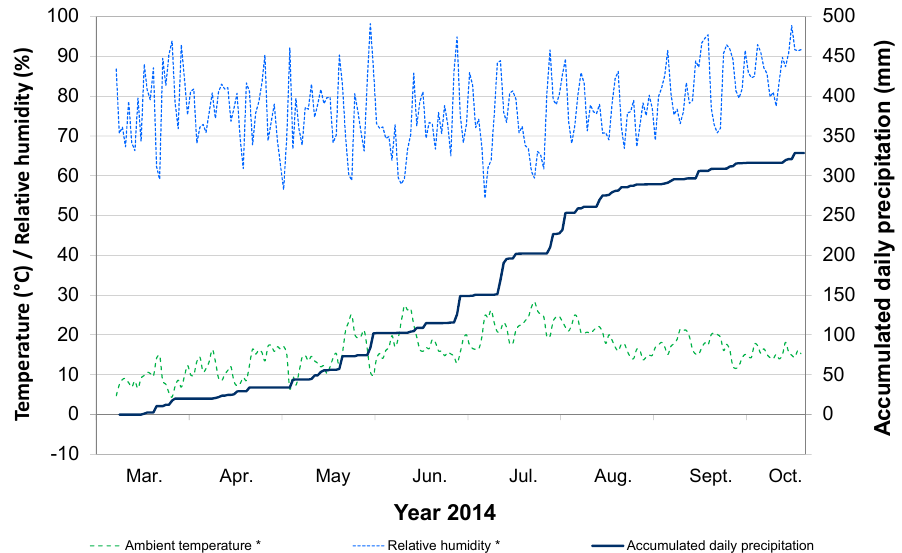
Figure 6. Weather conditions and temperature during storage trial P1 in Potsdam (* daily averages).